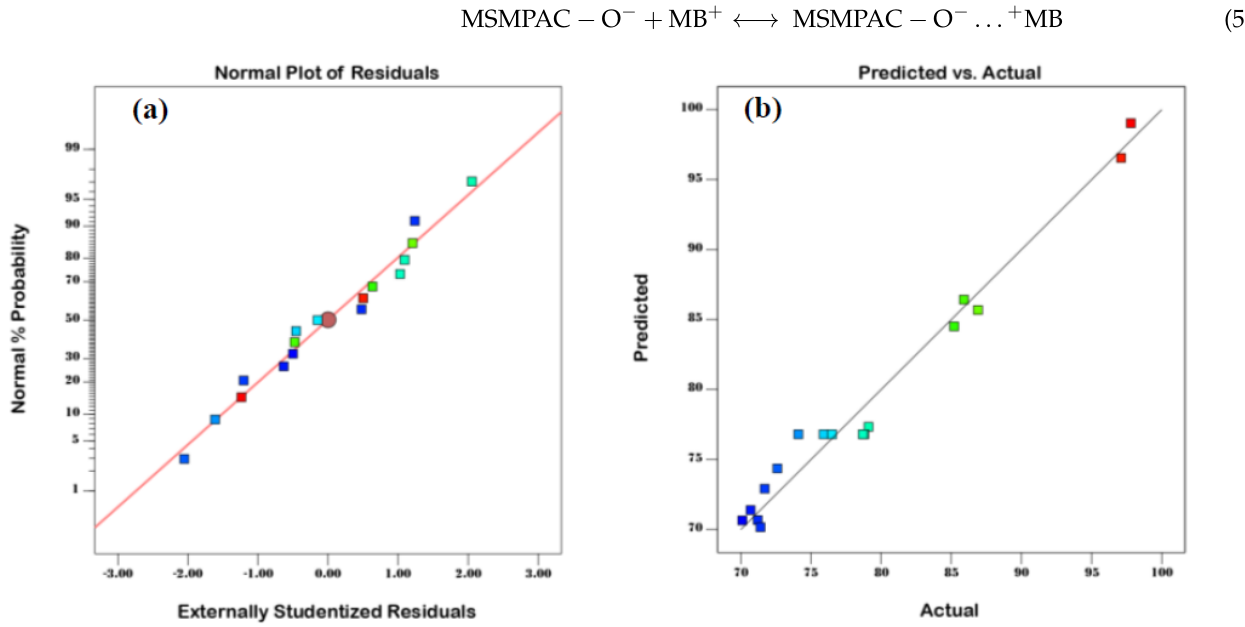
Figure 5. Plots illustrating ( a ) the normal probability of residuals and ( b ) the association between expected and real MB removal levels.